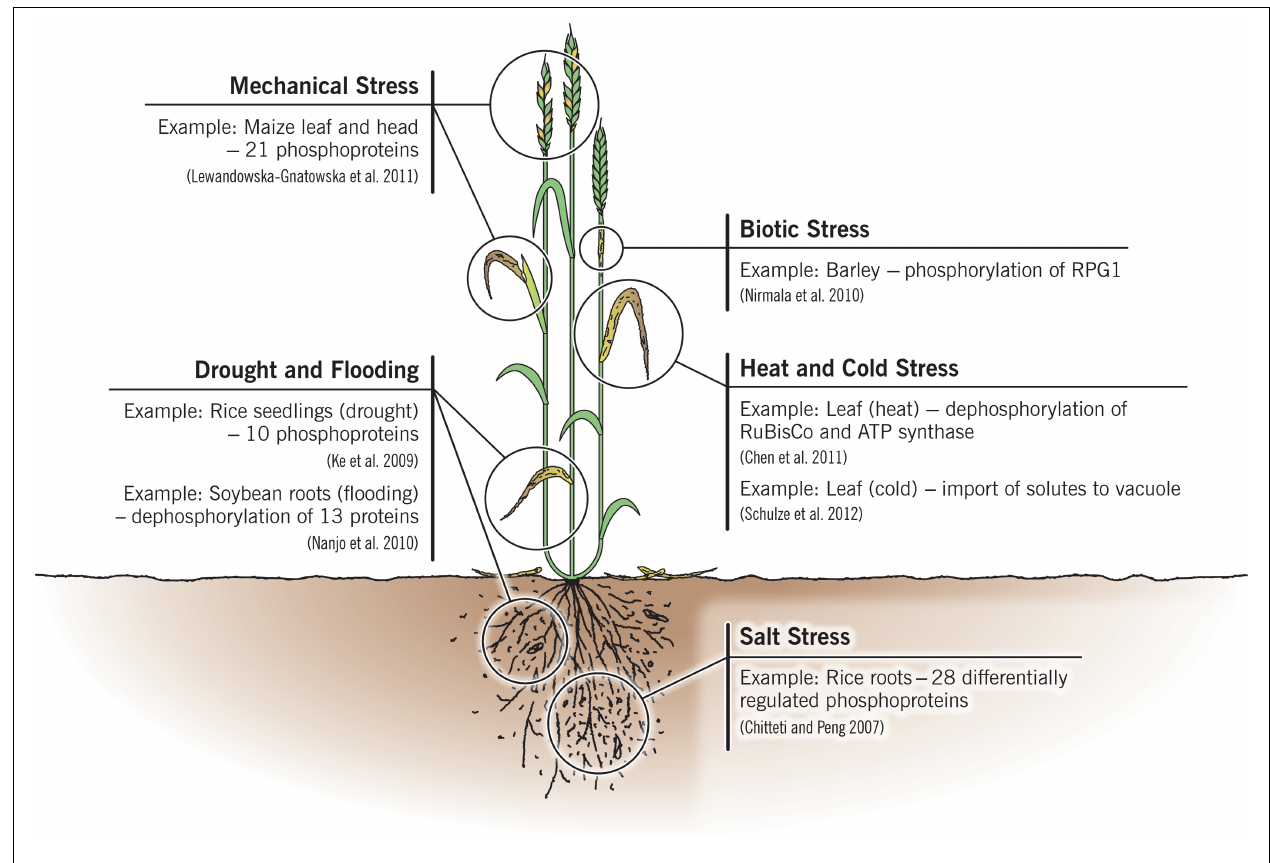
FIGURE 1 |A summary of the major categories of stresses which crops face routinely, showing their principal target organs and specific examples which are discussed in more detail in the text and inTable 1.